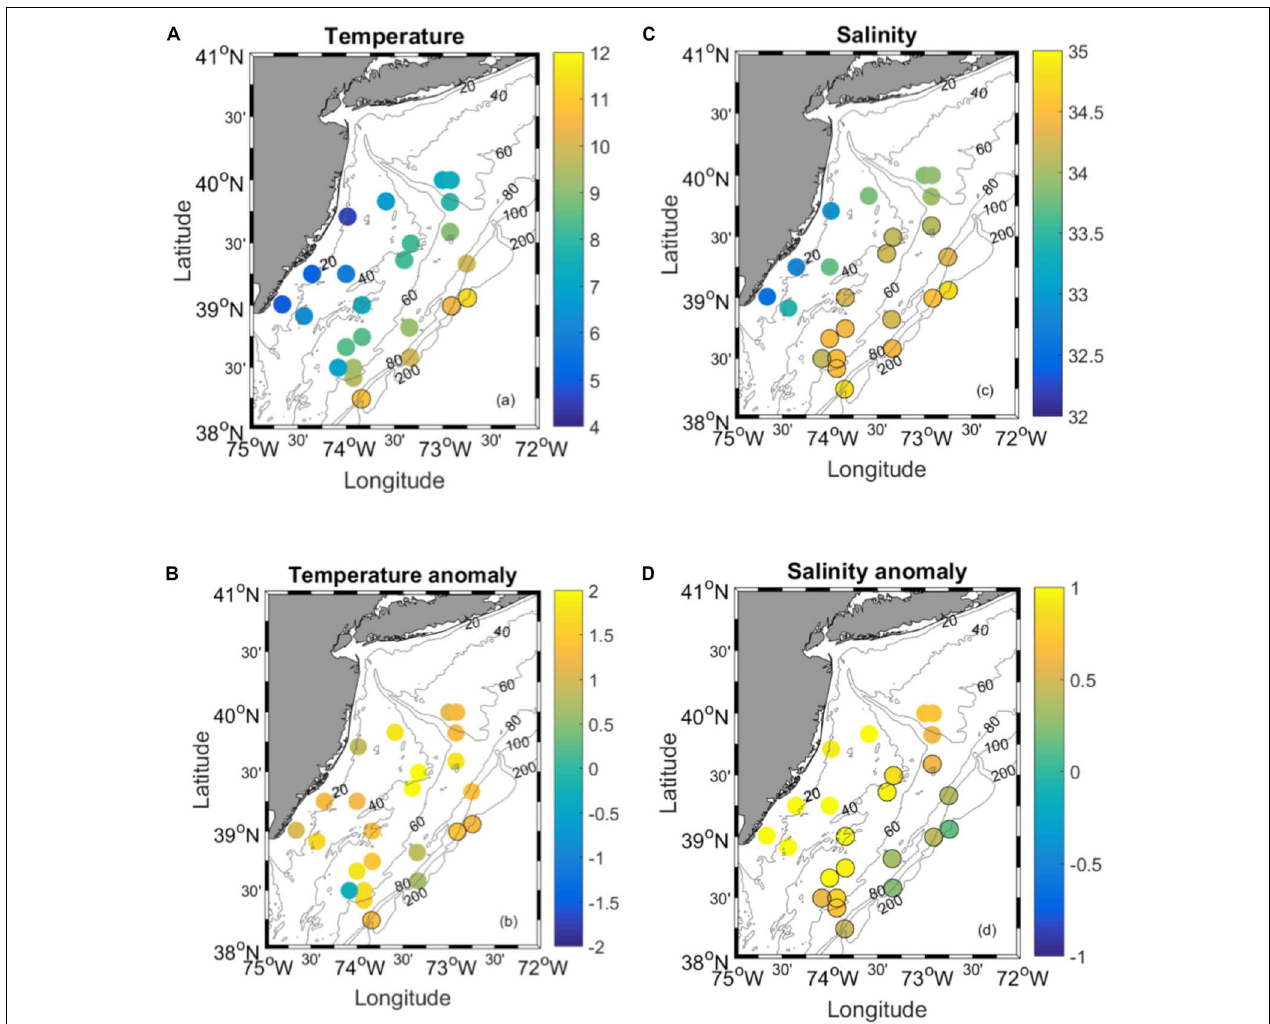
FIGURE 8 | (A) Depth averaged temperature from an ECOMON cruise of the R/V Bigelow in February 2017. Note the warm temperatures (8–9 ◦ C) extending to the 40 m isobath. (B) Temperature anomalies relative to the MOCHA climatology for January. (C) Depth-averaged salinity. Note that the 34.0 isohaline extends to the 40 m isobath, it is typically seaward of the 80 m isobath. (D) Salinity anomalies relative to the MOCHA climatology for January. The dark rings indicate stations in which either temperature is higher than 10 ◦ C or salinity is greater than 34.0